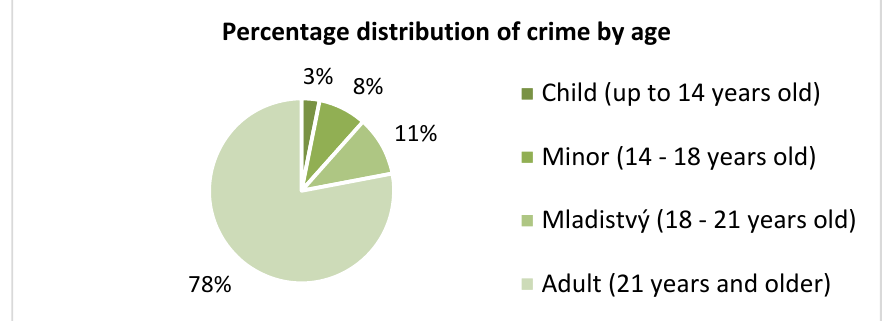
Figure 8. Graph of percentage distribution of crime in the Bavaria region by age in 2017 [adopted from 15]